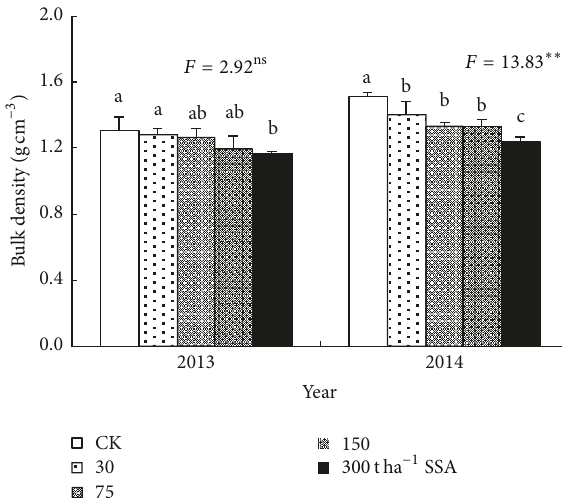
Figure 1: Effects of sewage sludge amendment (SSA) combined with green manuring on bulk density of coastal mudflat salt-soil. Vertical bars indicate standard deviations of the means. Columns with different letters show significant difference between sewage sludge amendment rates at 𝑝 < 0.05 by LSD’s multiple range test. Values of 𝐹 are the 𝐹 test in ANOVA; ∗∗ 𝑝 < 0.01 ; ns 𝑝 > 0.05